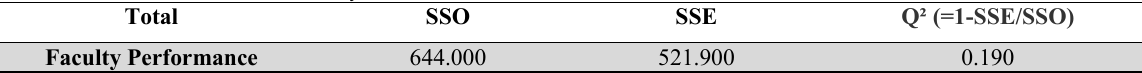
Construct Cross-validated Redundancy Total